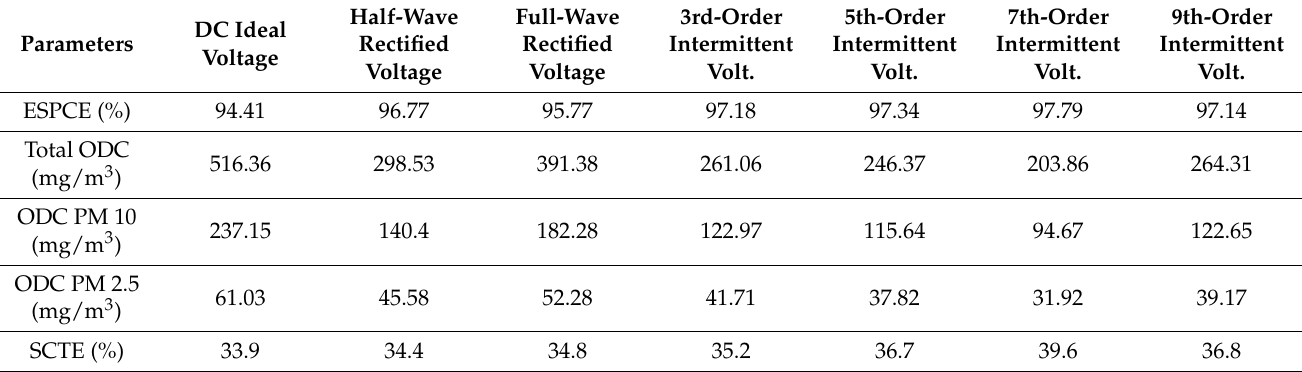
Table 13. Dust particle collection for various types of supply voltages when rapping the dust resistivity sections (10 12 Ω × cm).